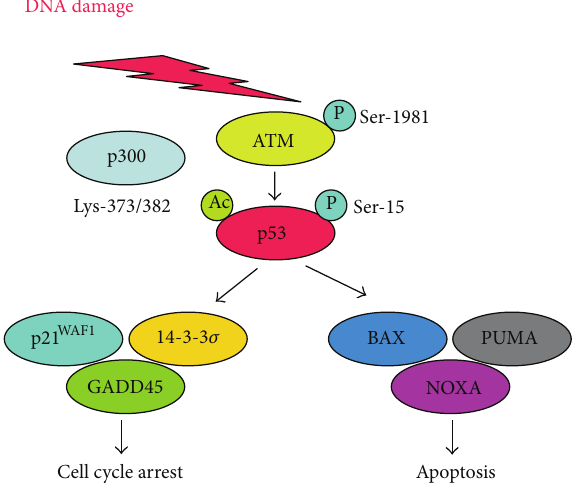
Figure 1: p53-dependent DNA damage response. Upon DNA damage, p53 is phosphorylated at Ser-15 and acetylated at Lys- 373/382 by ATM and p300, respectively. Activated form of p53 induces cell cycle arrest and/or apoptotic cell